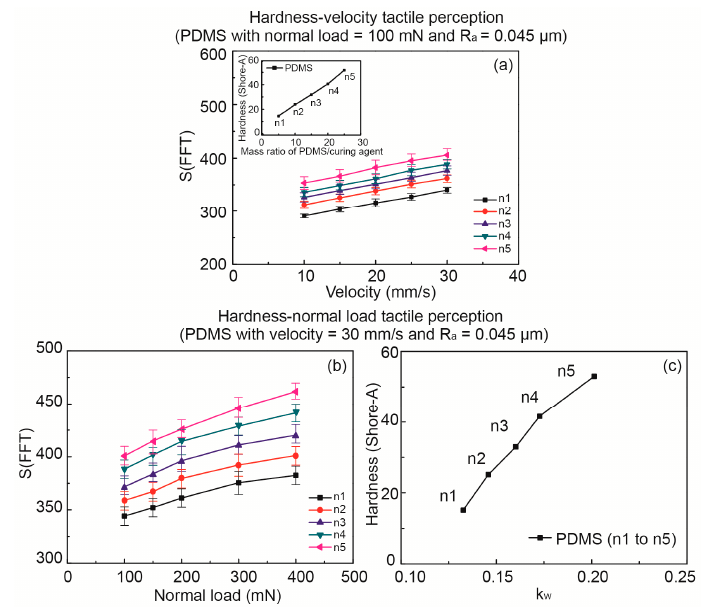
Figure 6. PDMS hardness tactile perception as a function of velocity and normal load. ( a ) Hardness-velocity tactile perception with the normal load equal to 100 mN; ( b ) Hardness-normal load tactile perception with velocity equal to 30 mm/s; ( c ) The correlation between PDMS hardness and k w values.